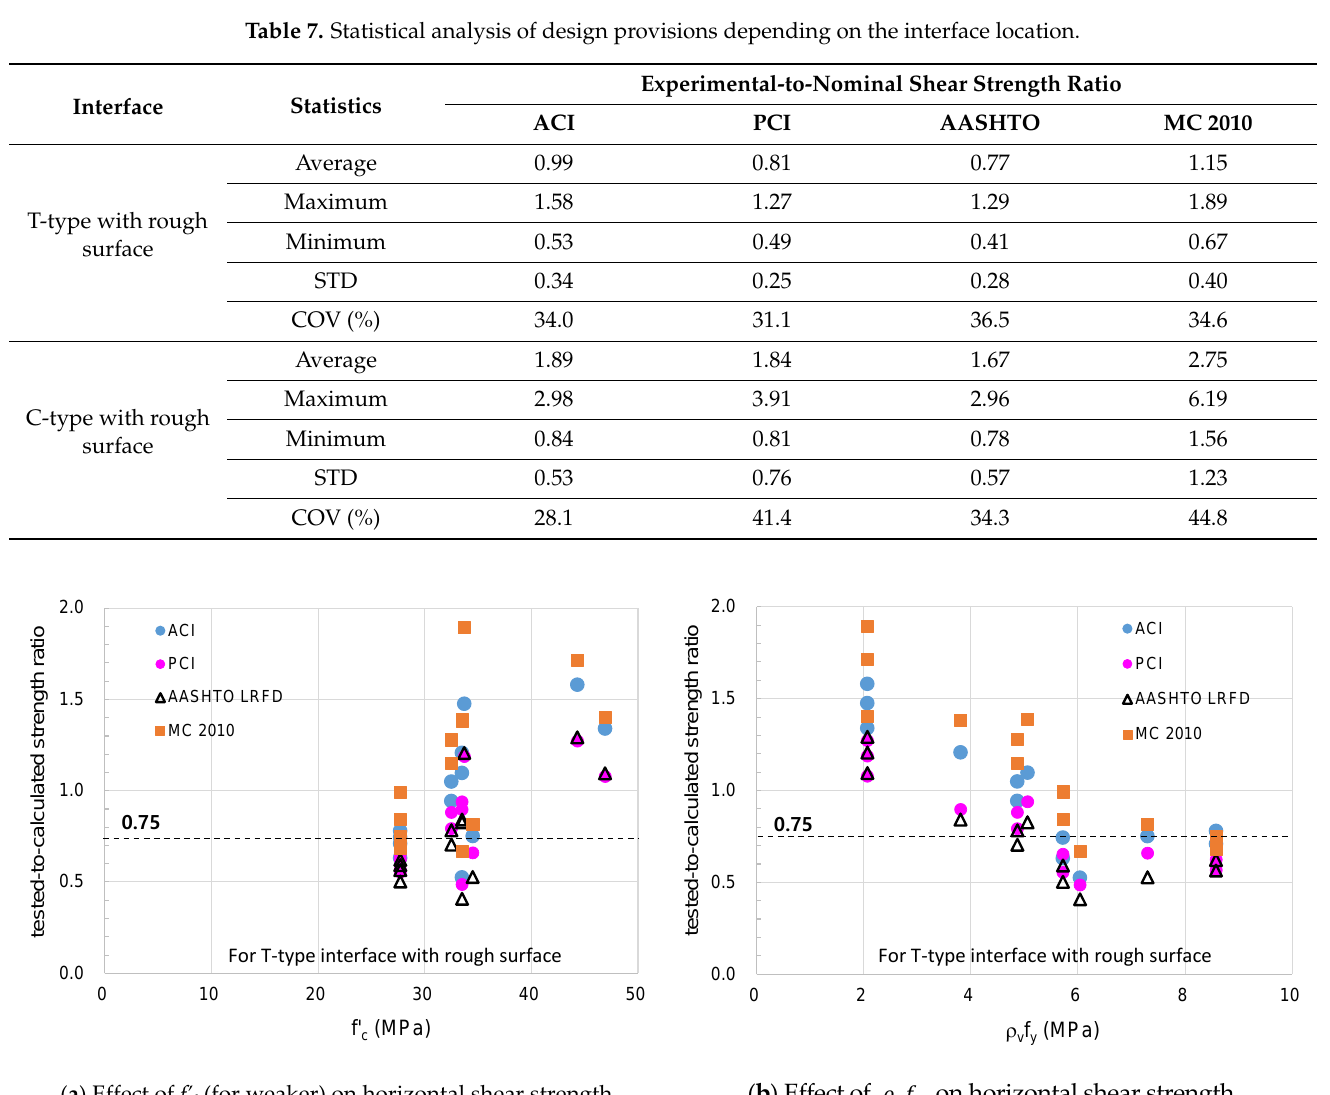
0.75 For C-type interface with rough surface